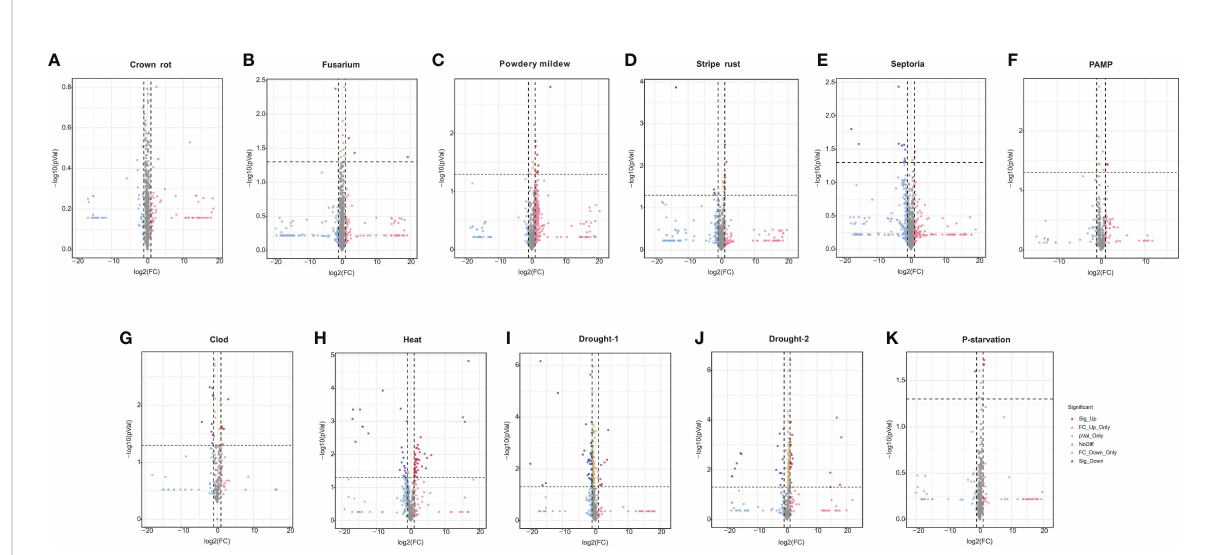
FIGURE 9 Expression of TaPHDs during different biological stress. Volcano map of expression pro fi les for 244 TaPHD genes under different biological/abiotic stresses, including (A) crown rot infection, (B) Fusarium infection, (C) powdery mildew infection, (D) stripe rust infection, (E) Septoria ( Septoria tritici infection and Zymoseptoria tritici infection), (F) PAMP (chitin and fl g22 infection), (G) cold stress, (H) drought-1 (drought stress in Giza 168), (I) drought-2 (drought stress in Gemmiza 10), (J) heat stress, and (K) P-starvation. DEGs were de fi ned as Fold Change > 1 and FDR < 0.05.